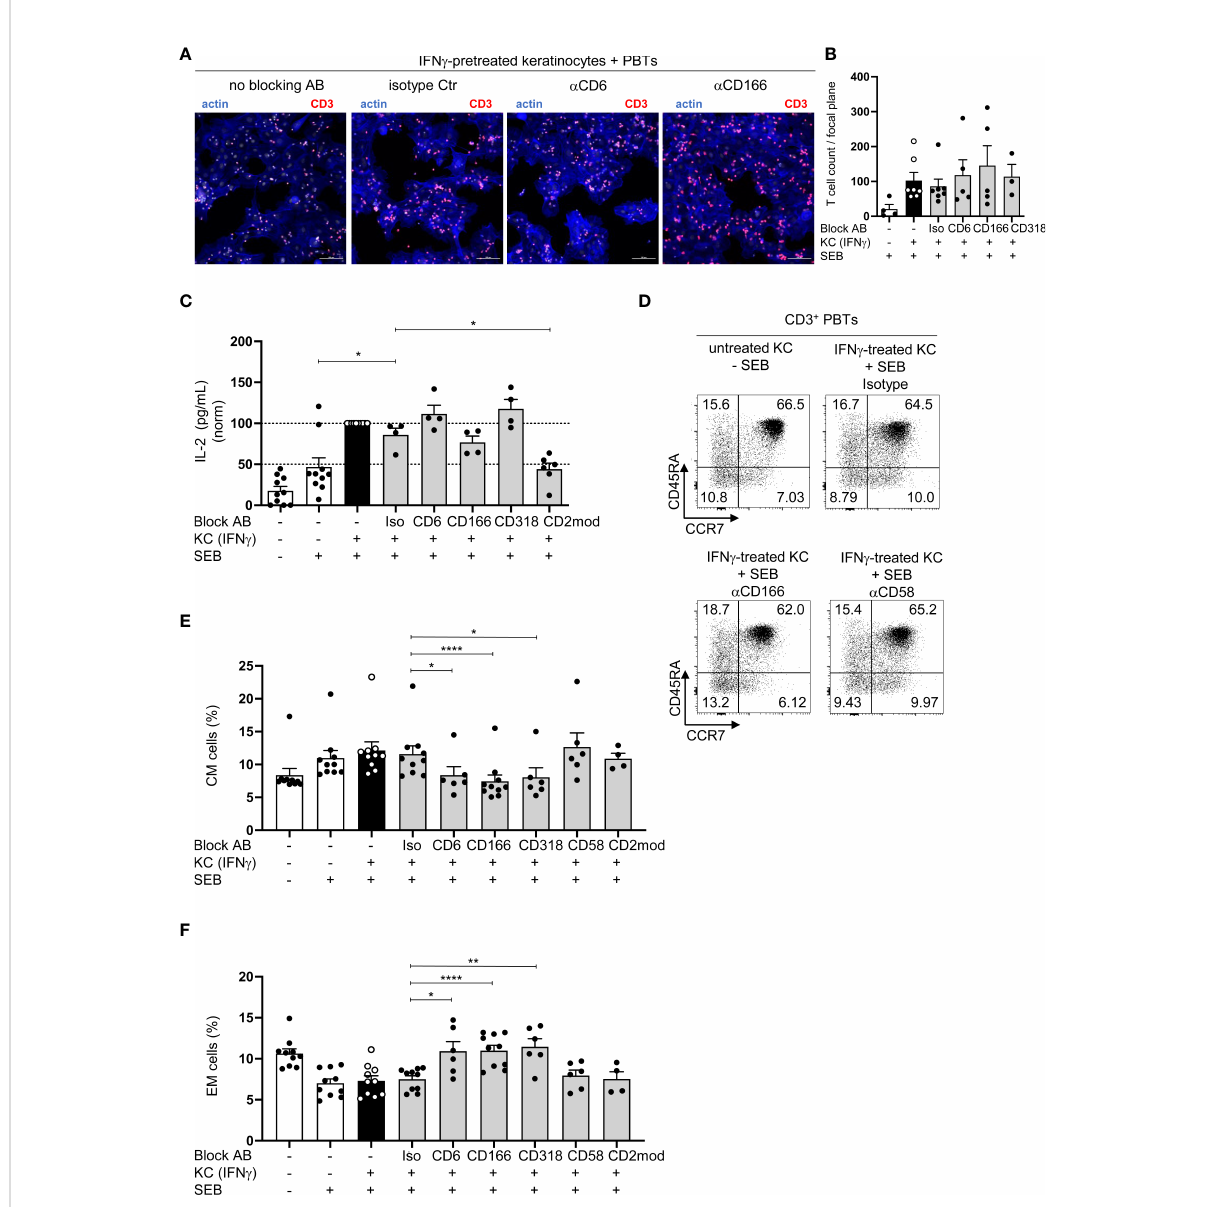
FIGURE 4 Blockade of CD6-mediated costimulation does not regulate IL-2 production but leads to an increase in EM and a decrease in CM cells. (A, B) Adhesion of CD3 + PBTs to IFN g -pretreated KCs (black and grey bars) loaded with SEB in the presence of blocking antibodies (as indicated). Cells were cocultured for 4 h and analyzed by confocal microscopy (20x objective; NA = 0.75). Adhesion was calculated as number of T cells per optical fi eld (n ≥ 3 individual T cell donors). (A) Representative immuno fl uorescence staining for F-actin in KCs and T cells (blue) and CD3 on T cells (red). (B) Statistical evaluation of the effect of blocking antibodies against CD6, CD166, or CD318, or isotype control antibodies (Iso) on the T cell adhesion to either untreated KCs (white bar) or IFN g -pretreated KCs (black bar and grey bars) loaded with (+) SEB. Data is represented as mean ± SEM. (C – E) CD3 + T cells were cultured for 24 h with untreated KCs (white bars) or IFN g -pretreated KCs (black and grey bars) loaded with (+) or without (-) SEB and then analyzed by fl ow cytometry. (C) Amount of secreted IL-2 after 24 h coculture (n ≥ 4 individual T cell donors). Concentration of secreted cytokines was analyzed by cytokine bead array. *=p<0.05. (D, E) : (D) Representative dot plots and statistical evaluation of the effect of blocking antibodies or isotype control antibodies after 72 h on percentages of T cell populations (E) central memory (CM, CD45RA - CCR7 + ) and (F)